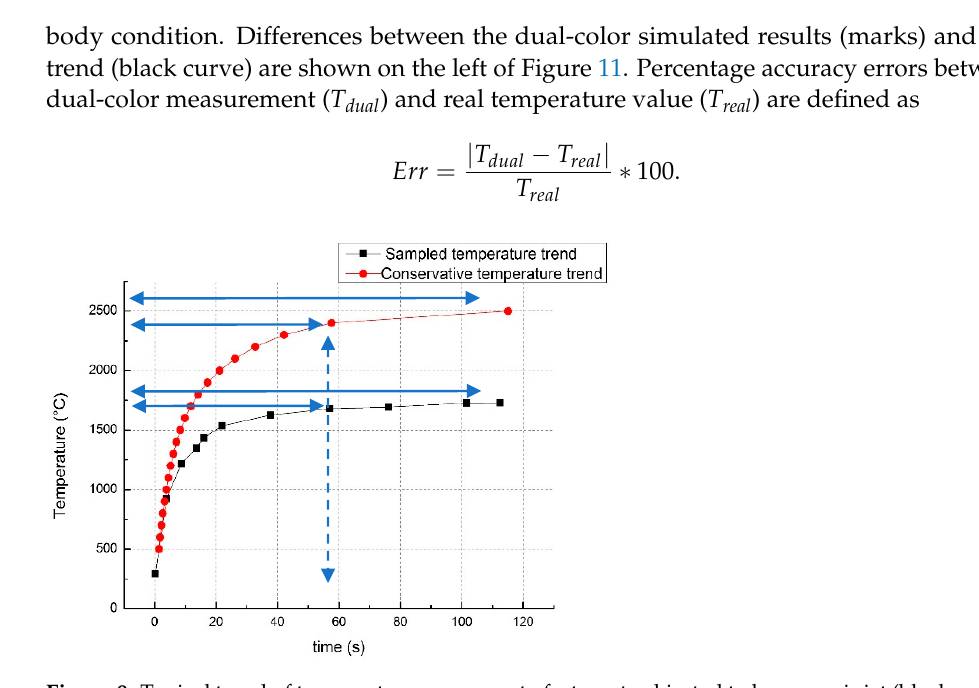
Figure 9. Typical trend of temperature over a spot of a target subjected to hypersonic jet (black–square points). Moreover, the most critical condition, in terms of heat flux extracted numerically from the previous curve, is shown in the red-circle points, see text.